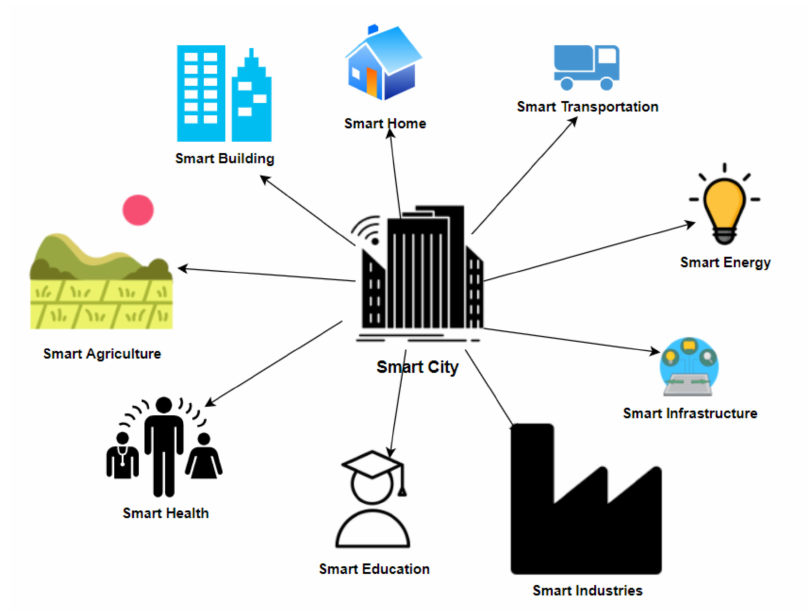
Figure 3. Smart cities